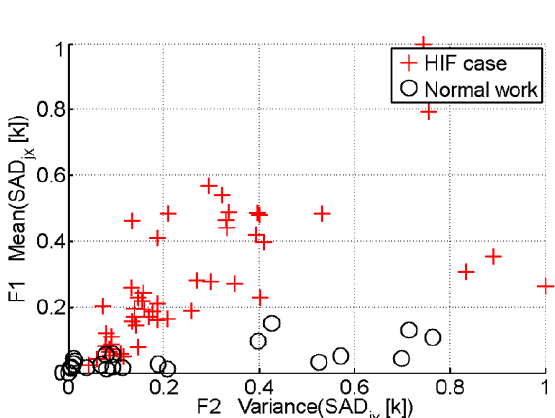
Figure 16. F1 versus F2 using (Vabc) with Mother WT demy and detail 6.